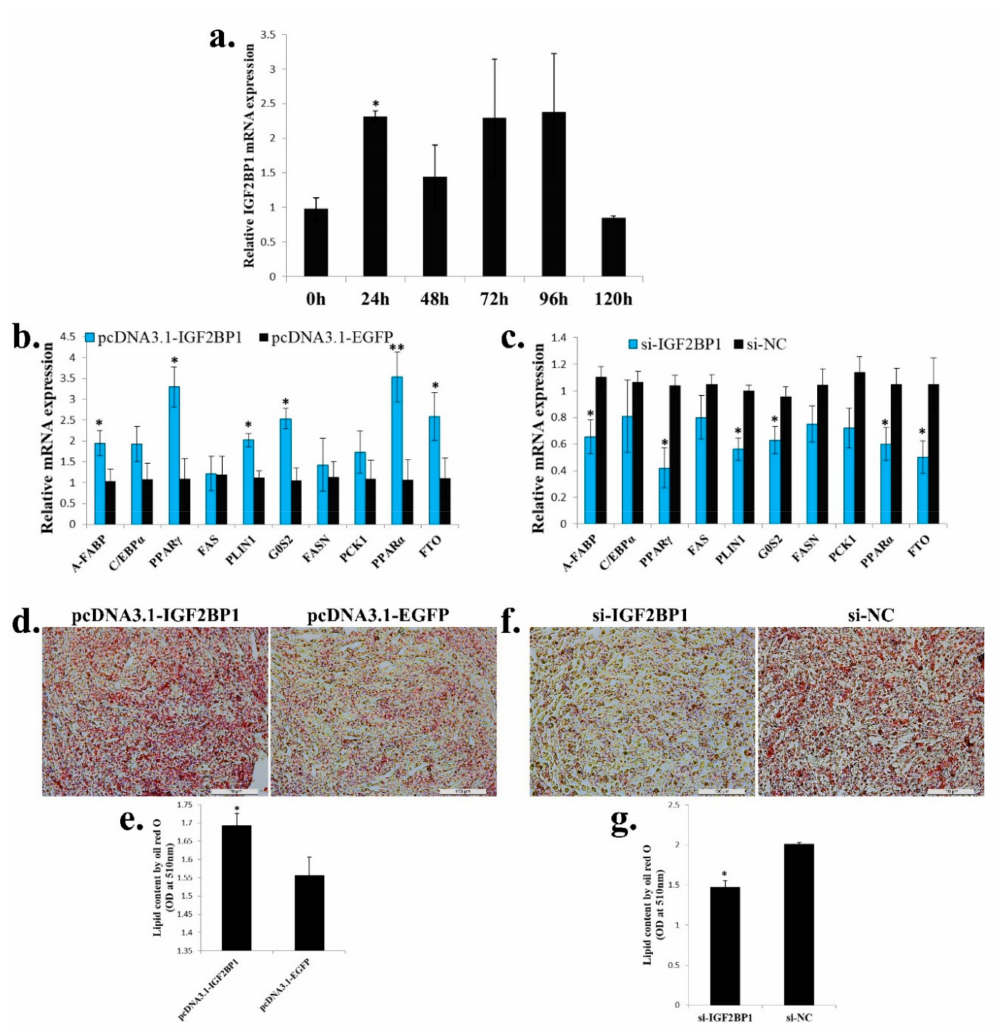
Figure 6. IGF2BP1 promotes chicken adipocyte di ff erentiation and increases lipid droplet accumulation. ( a ) The expression of IGF2BP1 during ICP cell di ff erentiation. ( b ) The expression of genes related to adipocyte di ff erentiation and fatty acid metabolism after IGF2BP1 overexpression in an ICP cell. ( c ). The expression of genes related to adipocyte di ff erentiation and fatty acid metabolism after inhibition of IGF2BP1 expression in an ICP cell. ( d ). Representative images of oil red O staining (red) after overexpression of IGF2BP1 in an ICP cell; scale bar: 100 µ m. ( e ). Lipid droplet content by oil red O staining and extraction method of cells transfected with IGF2BP1 overexpression vector. ( f ) Representative images of oil red O staining (red) after inhibition of IGF2BP1 in an ICP cell; scale bar: 100 µ m. ( g ). Lipid droplet content by oil red O staining and extraction method of cells transfected with si-IGF2BP1 and si-NC. The data are mean ± S.E.M. with four samples ( n = 4 / treatment group). Independent sample t test was used to analyze the statistical di ff erences between groups. * p < 0.05; ** p <